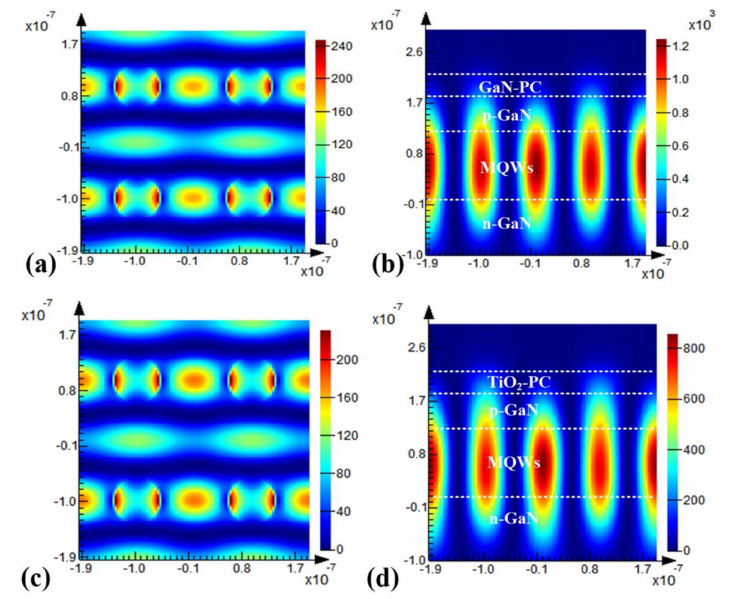
Figure 5. Field distribution in PhC surface plane ( a , c ) and cross-section plane ( b , d ) of the PCSELs with lattice constant 194 nm, hole radius 40 nm, hole depth 40 nm of GaN-PhC ( a , b ) and TiO 2 -PhC ( c , d ) at resonant peaks of 450.95 nm and 451.67 nm, respectively.